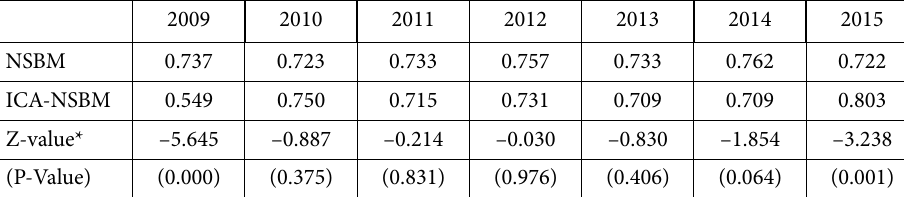
Table 7. Wilcoxon signed-rank test between ICA-NSBM model and NSBM